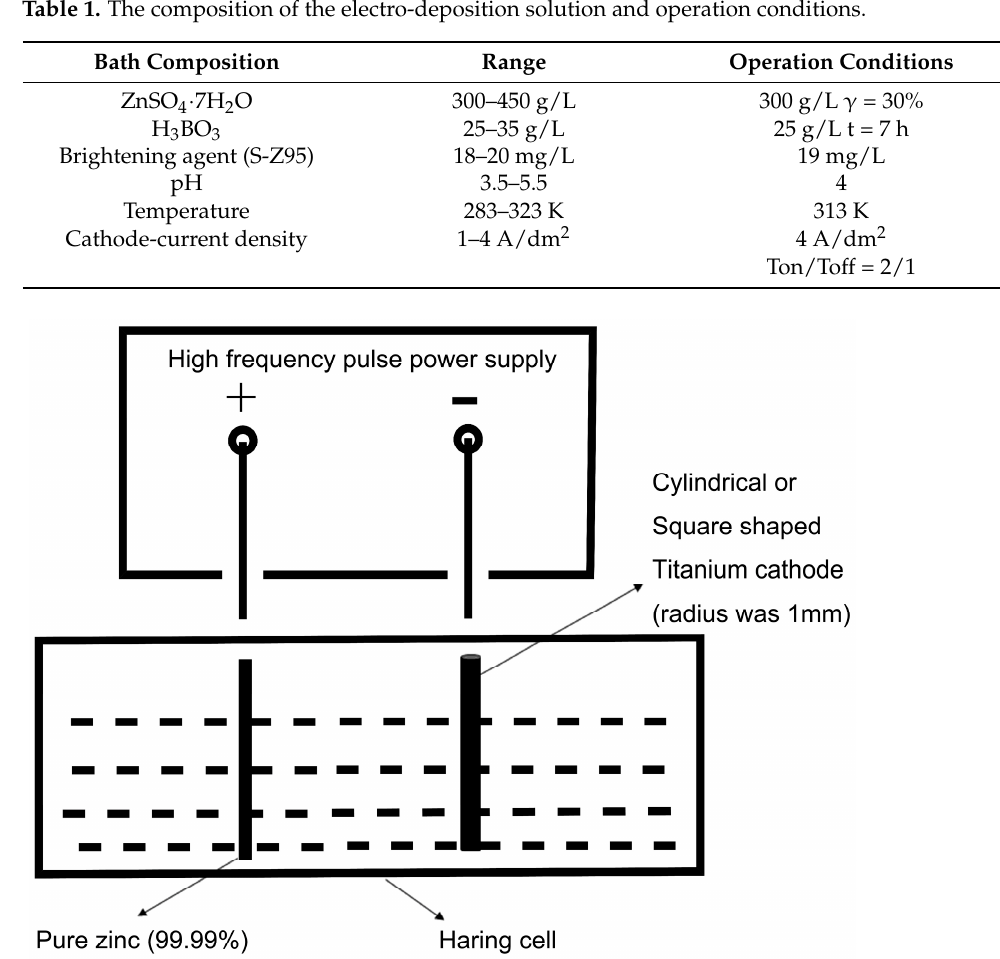
Figure 1. The schematic diagram of the experiment